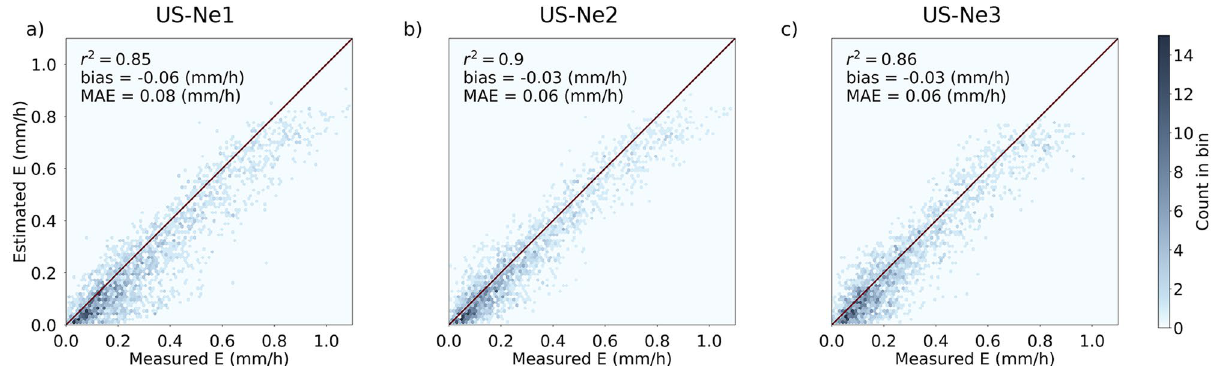
Figure 5. Scatter plots of CubeSat-based E against residual corrected eddy covariance E fluxes for each of the US-Ne1, US-Ne2, and US-Ne3 field